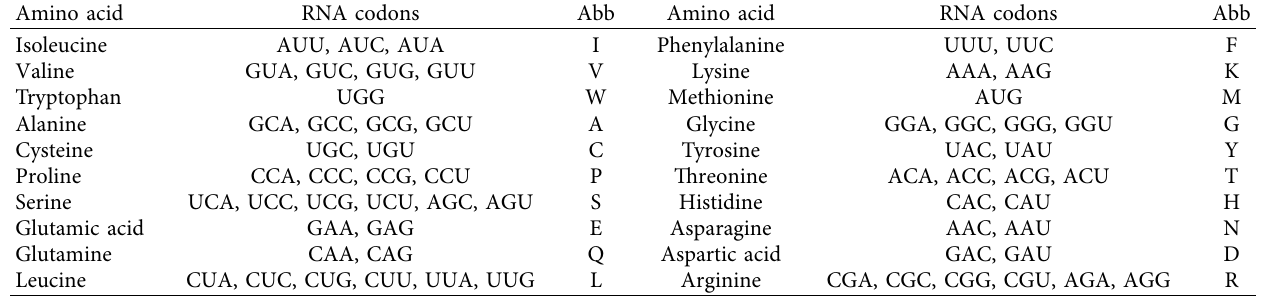
Table 3: Amino acids and RNA codons.